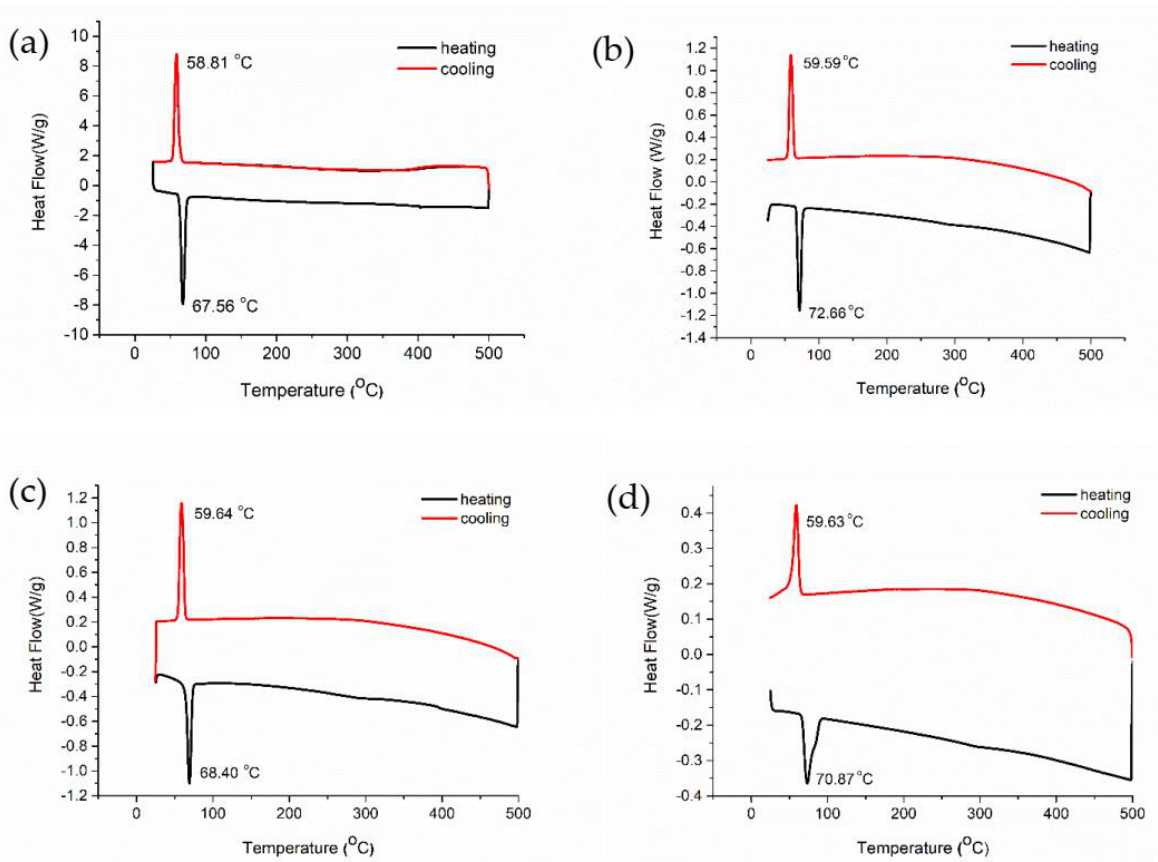
Figure 4. DSC graphs of ( a ) asterisk-like VO 2 ( b ) urchin-like VO 2 ( c ) multifaceted spherical-like VO 2 ( d ) nanotubular VO 2. DSC graph of urchin-like VO 2 is given in Figure 4b, which shows an endothermic peak at 72.66 ◦ C during heating and an exothermic peak at 59.59 ◦ C during cooling. Multifaceted spherical-like VO 2 sample shows an endothermic peak at 68.40 ◦ C upon heating and an exothermic peak at 59.64 ◦ C upon cooling without any other phase transitions, as shown in Figure 4c. Figure 4 points out the striking difference in the heating and cooling